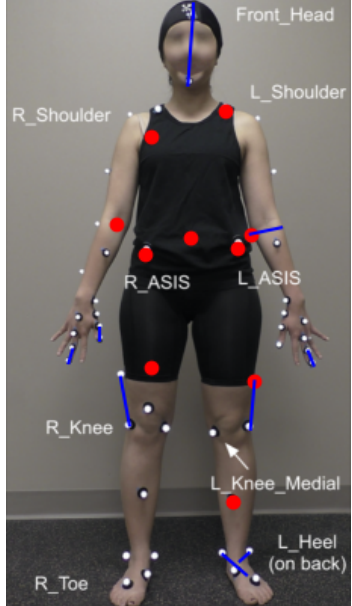
Figure 4. Kinematic markers (referred to as “joints” in pose estimation literature, red) and segments (referred to as “limbs” in pose estimation literature, blue) with the top 10 attention weights in the prediction